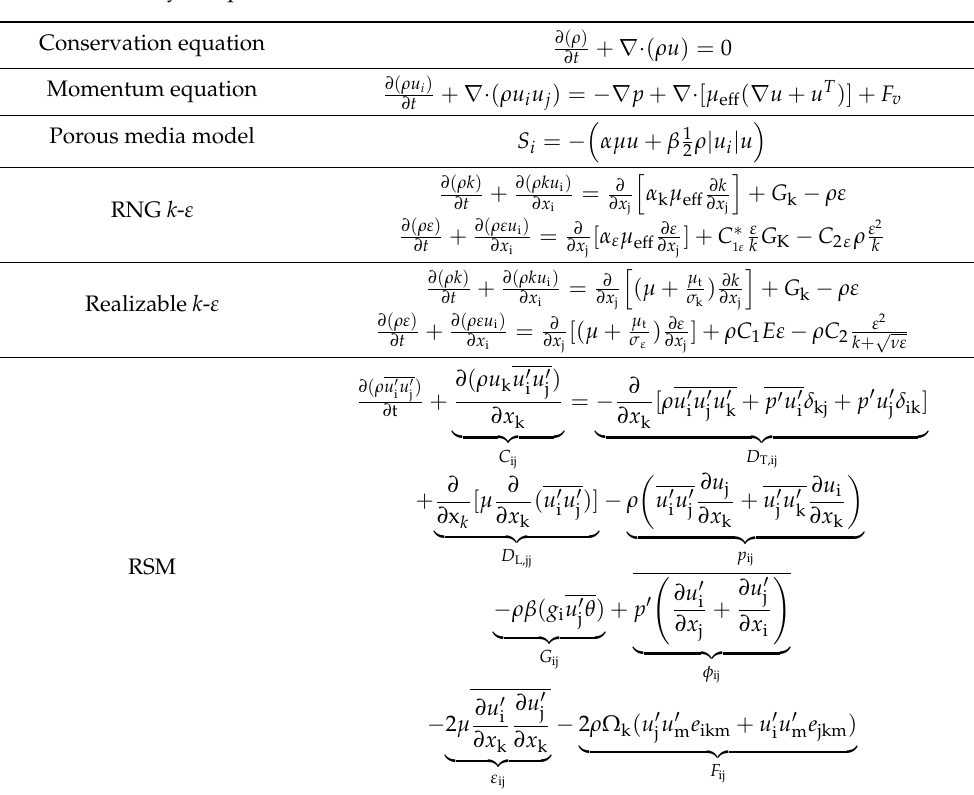
Table 2. Summary of equations.